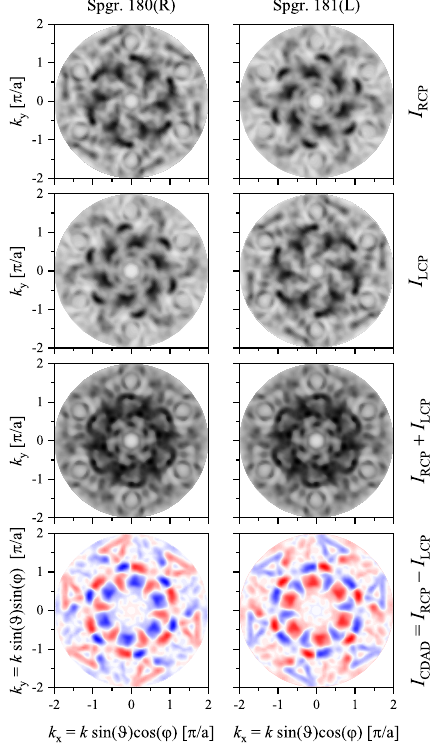
Figure 20. CDAD from VSi 2 (0001). The intensity distributions for excitation by circularly polarized photons of opposite helicity with normal incidence (that is along the (0001) surface normal) are shown. The intensities and circular dichroism (CDAD) from crystals belonging to the two space groups with opposite handedness are